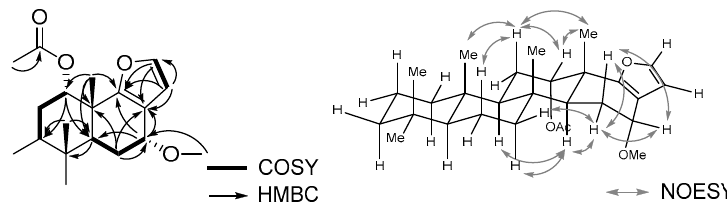
Figure 3. Selected COSY, HMBC, and NOESY correlations for compound 5 .